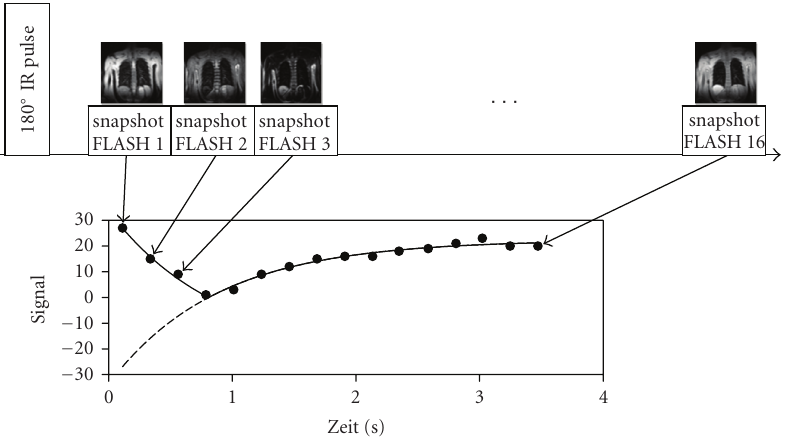
Figure 3: T1 Measurements: after a 180 ◦ inversion pulse, 16 Images were acquired at specific time points using a snapshot FLASH sequence. The individual measurements have a duration of 224 milliseconds, the complete slice 3,5 seconds. Due to the short acquisition time, patients with moderate dyspnea can be examined using this method. An exponential function was assigned to each Pixel covering the time span of the 16 measured signal intensities from which a Pixel T1 time can be calculated. The final T1 map results from the color coding of the T1